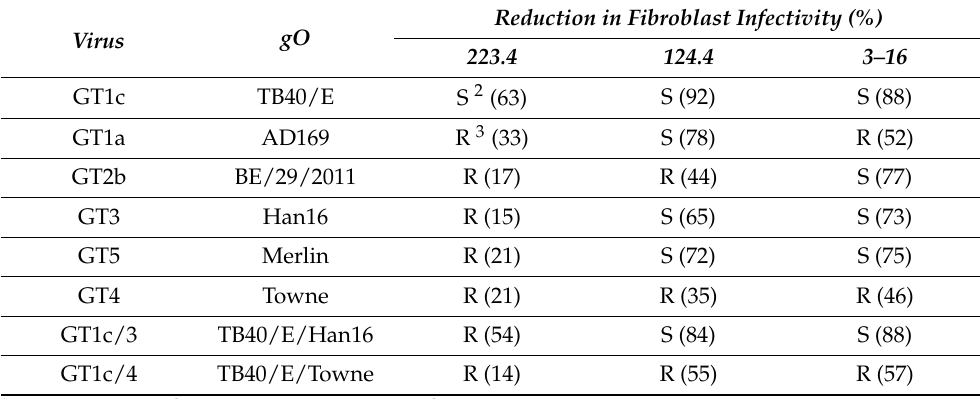
Table 3. Reduction in fibroblast infectivity following mAb neutralization 1 .